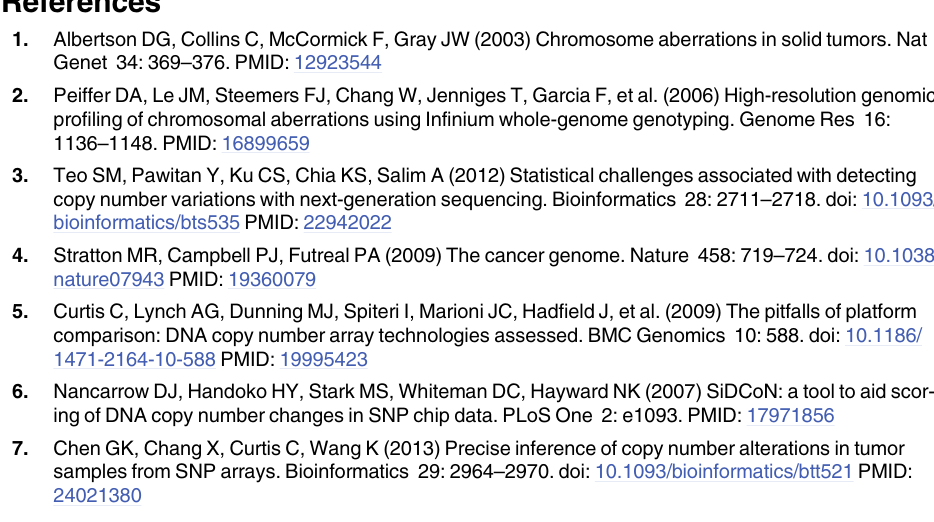
S3 Fig. Assessment of genomic aberration identification for TAFFYS using dilution series data. Genome-wide amplification (red) /deletion (blue) profiles for dilution samples with can- cer cell content ranging from 30% to 100%. S4 Fig. Aberration identification of TAFFYS using lung cancer H1395. The results of genome-wide aberration identification on chromosome 10 using lung cancer H1395. For the BAF panel, LOH region is marked with blue, while non-LOH region with gray. For LRR panel, amplification is colored with red, and deletion with green. Black dots denote the signals after performing de-noising. For copy number (CN) panel, red line correspond to the copy number, and blue dots denote the goodness scores, which are only plotted when they are smaller than 0.05. S5 Fig. Comparison of genomic aberration identification of TAFFYS between GenomeWi- deSNP6.0 and Mapping500k. The results of genome-wide aberration identification using lung cancer H1395, which are analyzed by TAFFYS using Affymetrix GenomeWideSNP6.0 (bot- tom) and Affymetrix Mapping 500k (top). S1 Table. Detailed information of hidden states in TAFFYS. S2 Table. Detailed information of eliminated